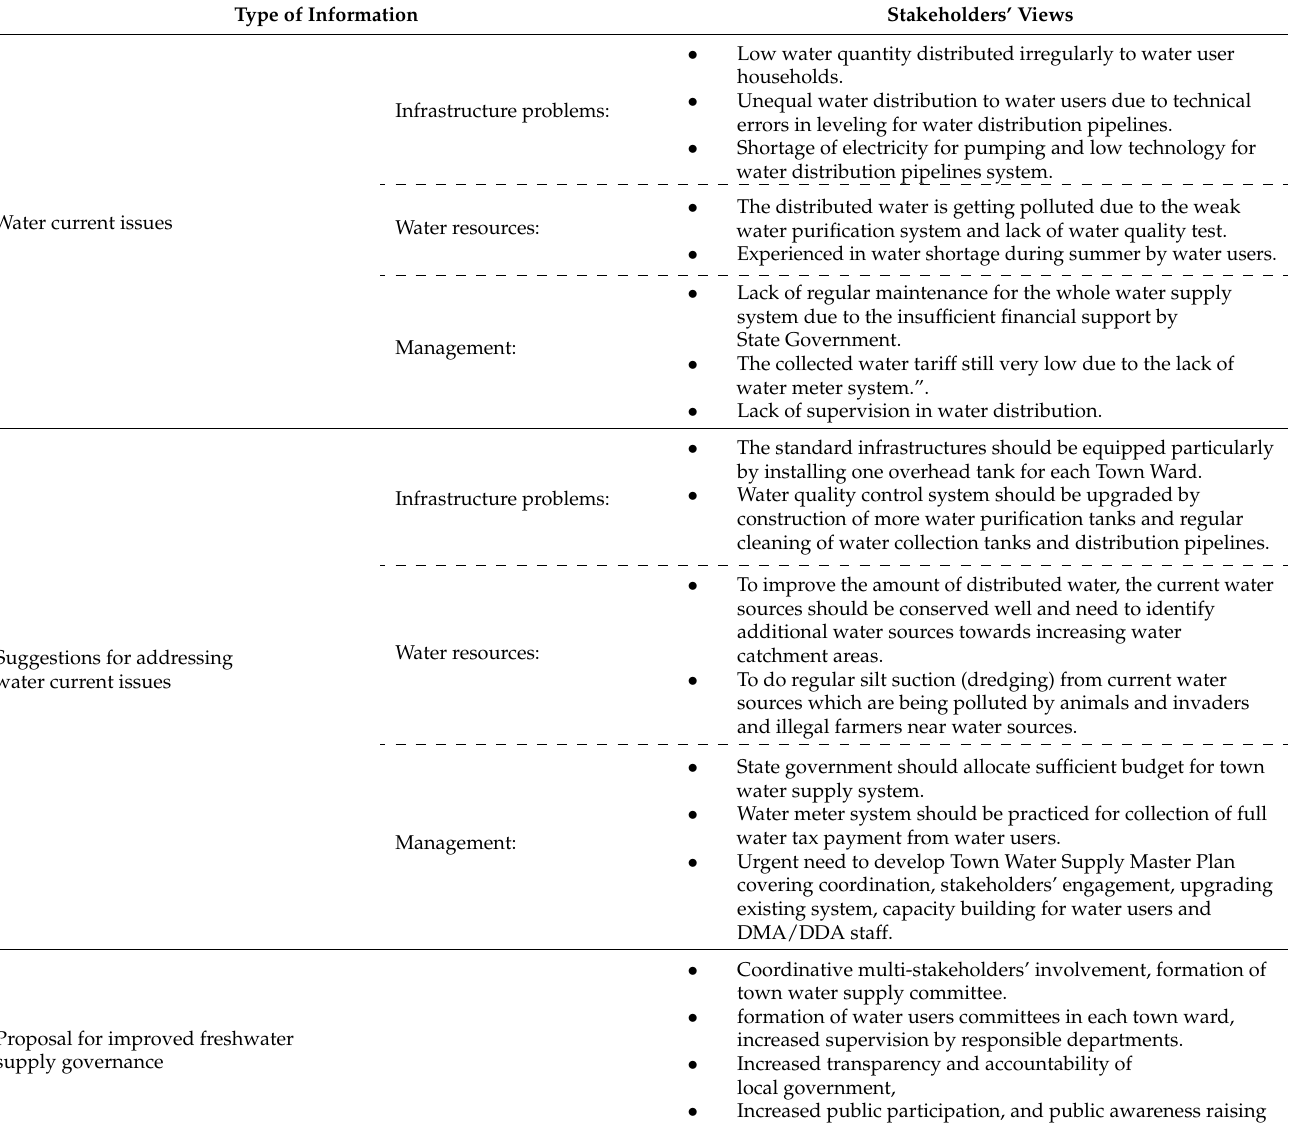
Table 3. Stakeholders’ views on current state of freshwater management in